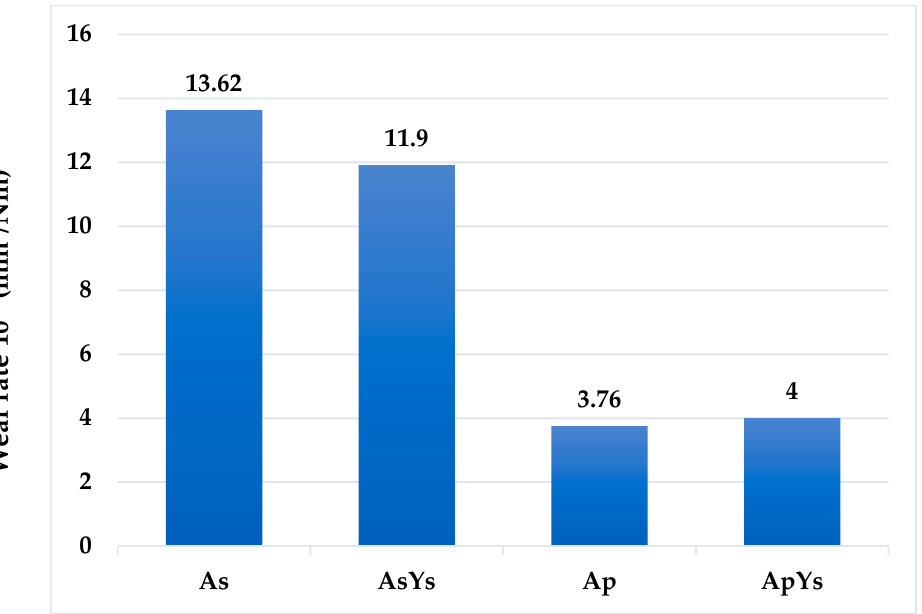
Figure 9. Specific wear rates of As, AsYs, Ap, and ApYs coatings.